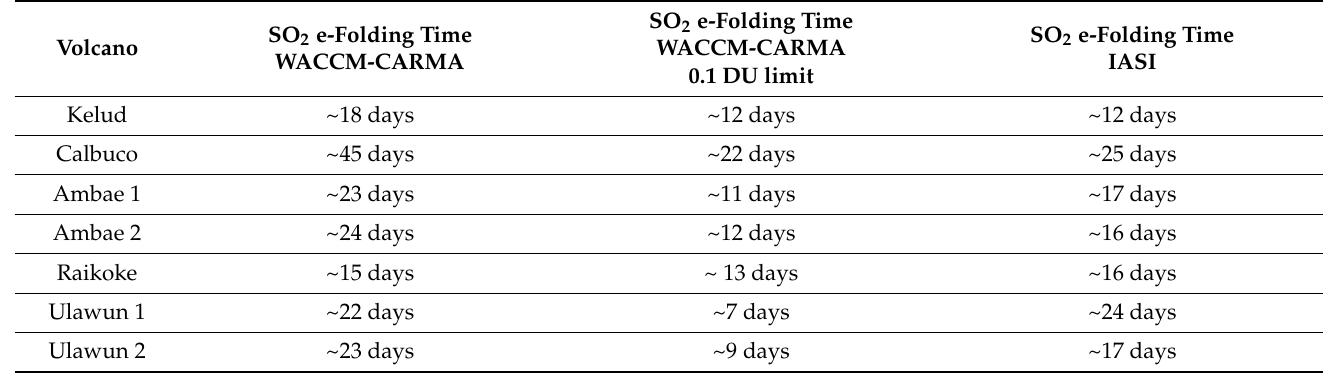
Table 2. E-folding times for SO 2 derived from WACCM-CARMA simulations and IASI observations. For the sake of the comparison with the satellite data, a detection limit of 0.1 DU is